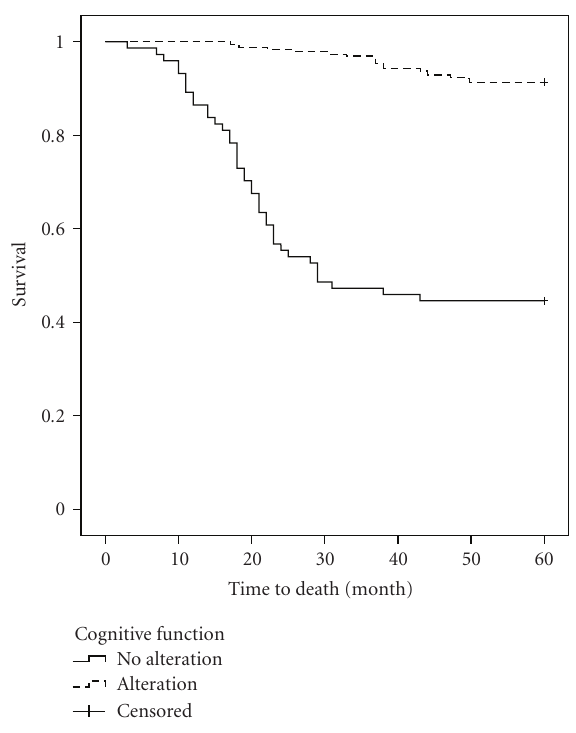
Figure 2: The Kaplan-Meier curve for cognitive function according to the two groups, during the follow-up